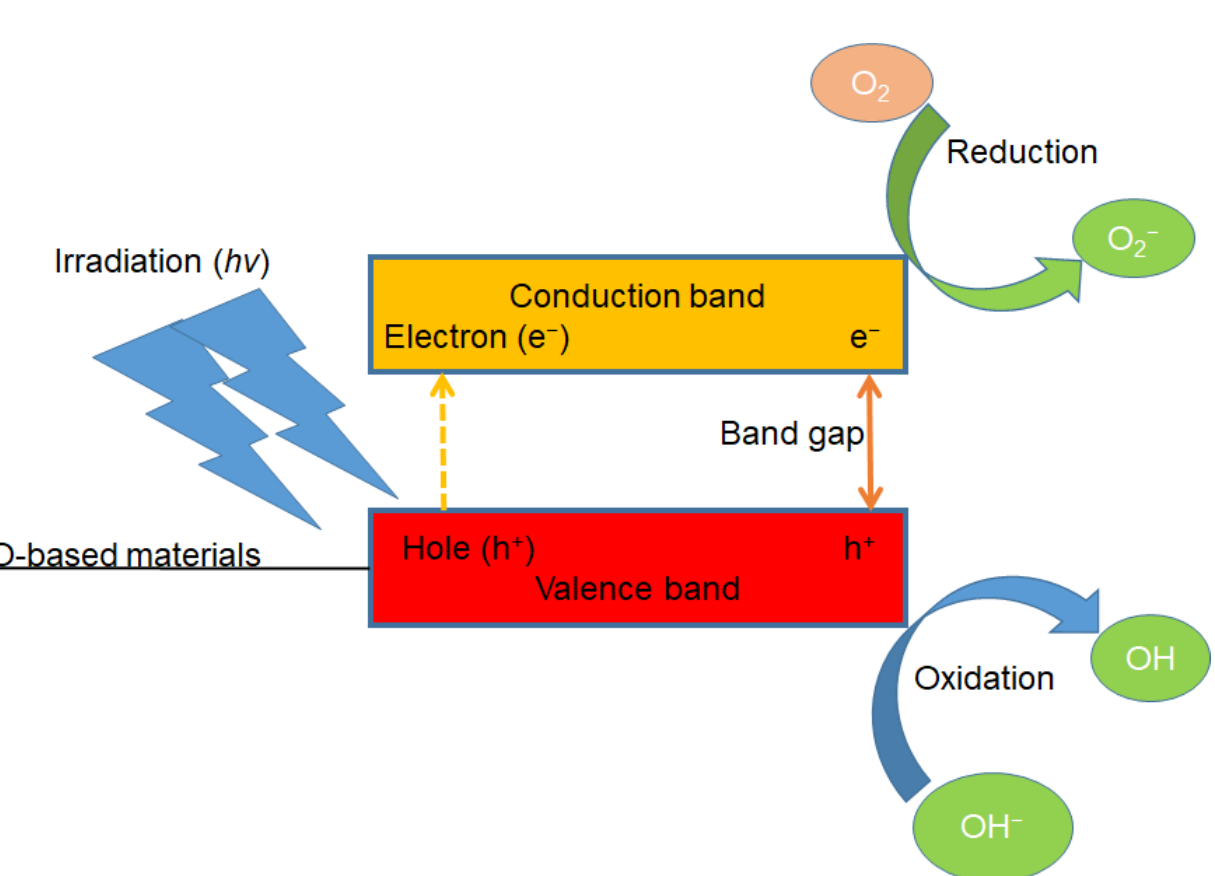
Figure 3. A schematic representation of the photocatalytic mechanism.